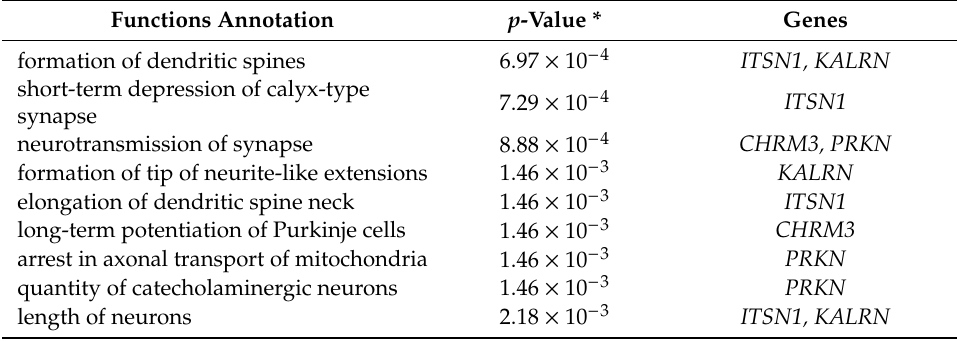
Table 6. Neurological functions associated with genes implicated by play skills